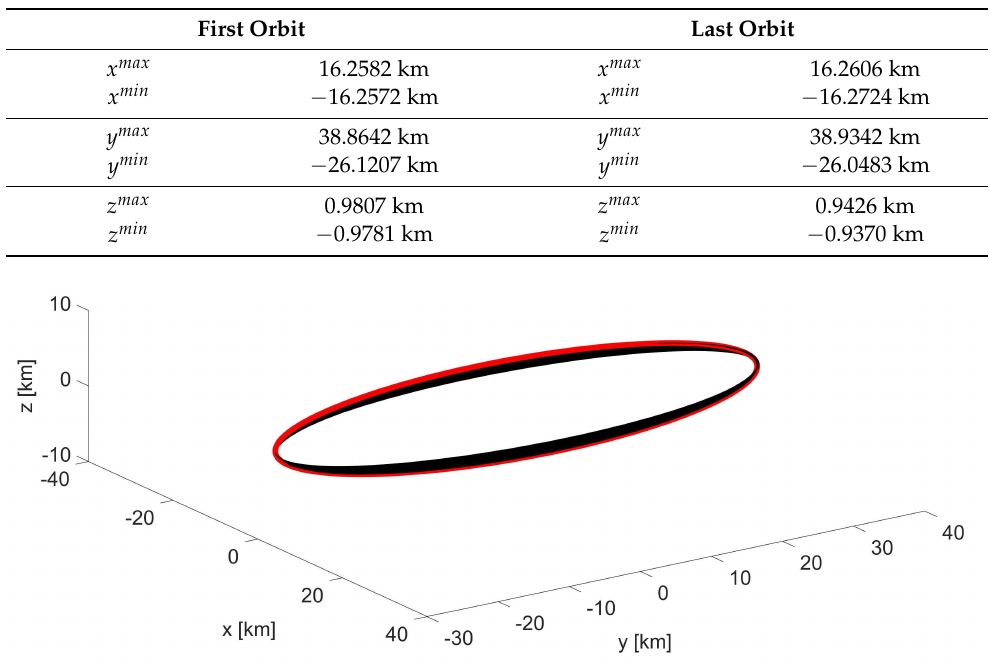
Table 3. SSO formation: maximum and minimum value of the position coordinates for the first and the last orbit.